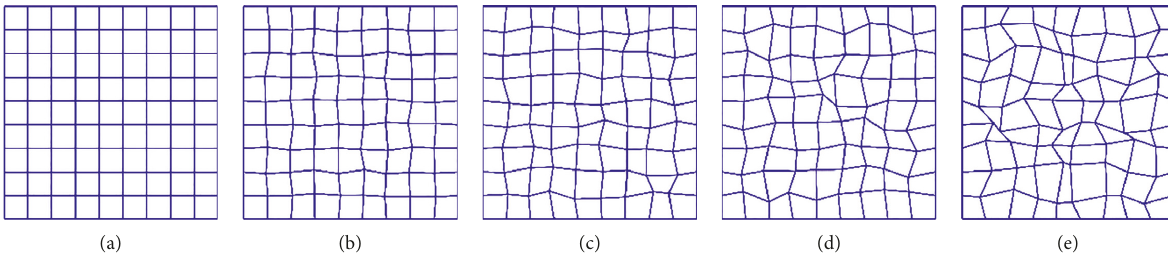
� 0 . 1; (c) irregularity coefficient α � 0 . 2; (d) r r